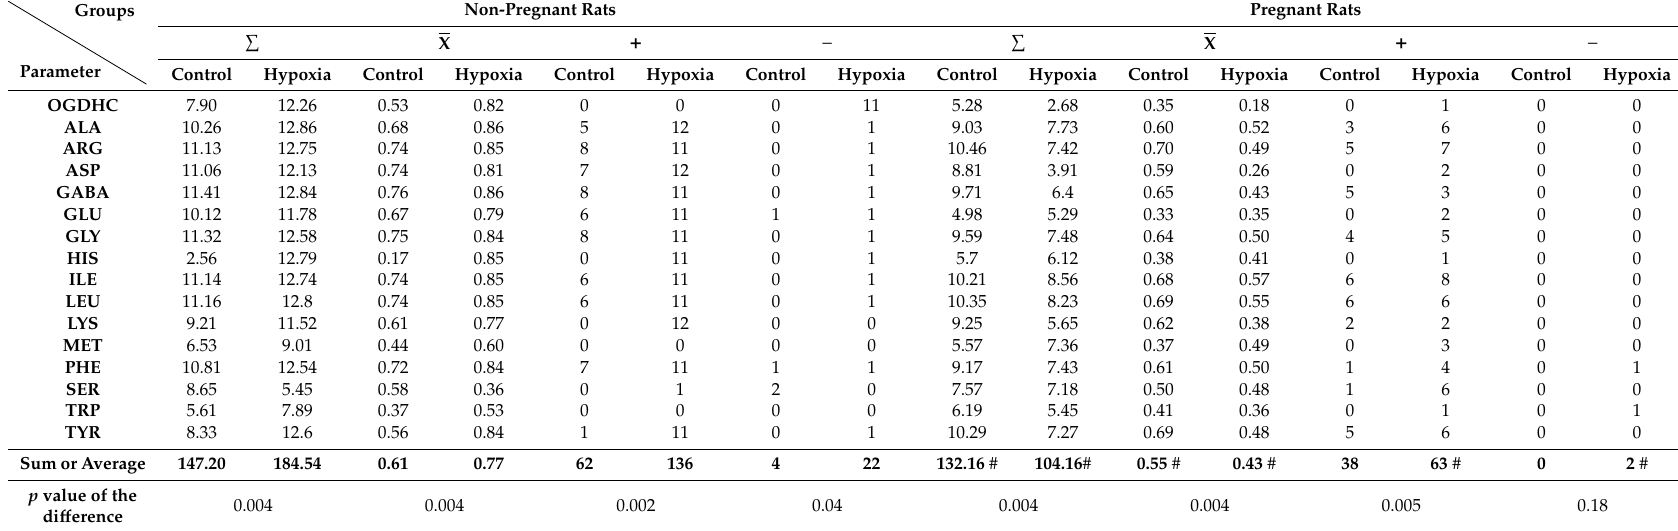
Table 4. Analysis of the hypoxia-induced changes in interdependence of the levels of amino acids and OGDHC activity in cerebella of the non-pregnant and pregnant